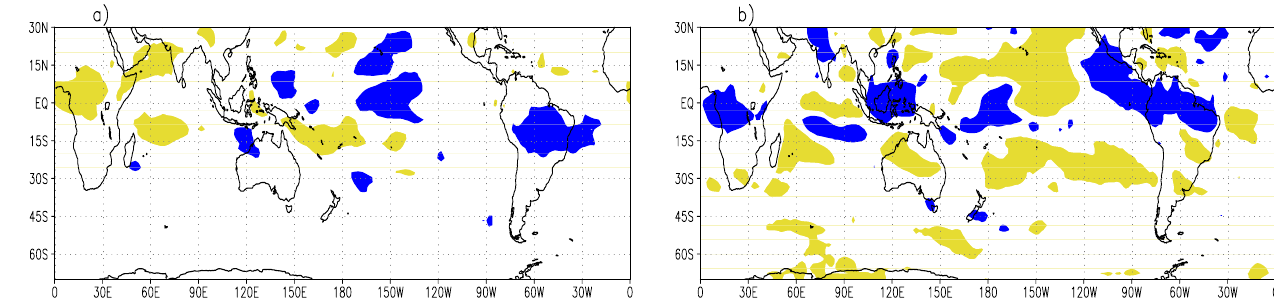
− 2 ) for the GF winters of (a) + σ and (b) − σ . Light (dark) shade indicates values smaller than − 6Wm − 2 Figure 1: Fig. 1. OLR anomalies (Wm